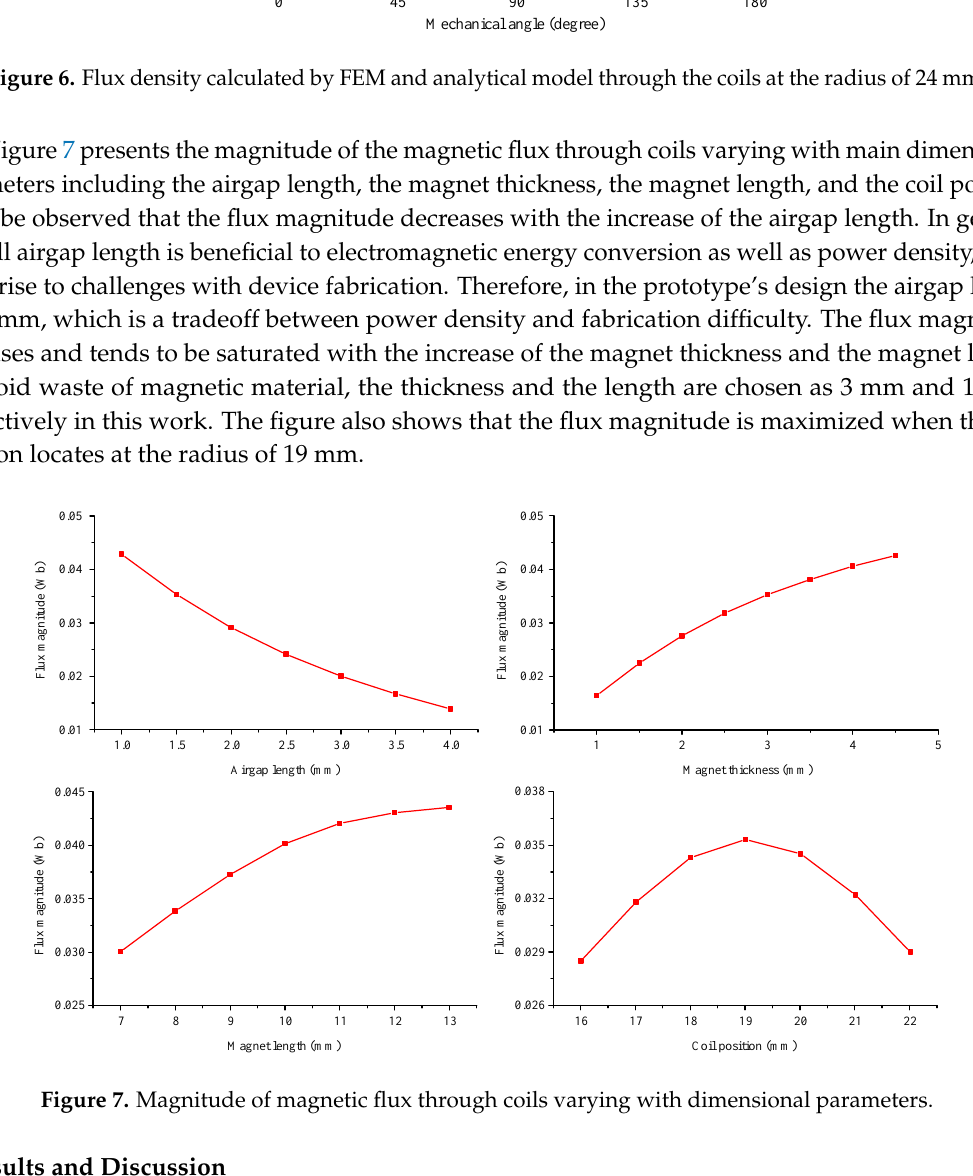
Figure 6. Flux density calculated by FEM and analytical model through the coils at the radius of 24 mm.